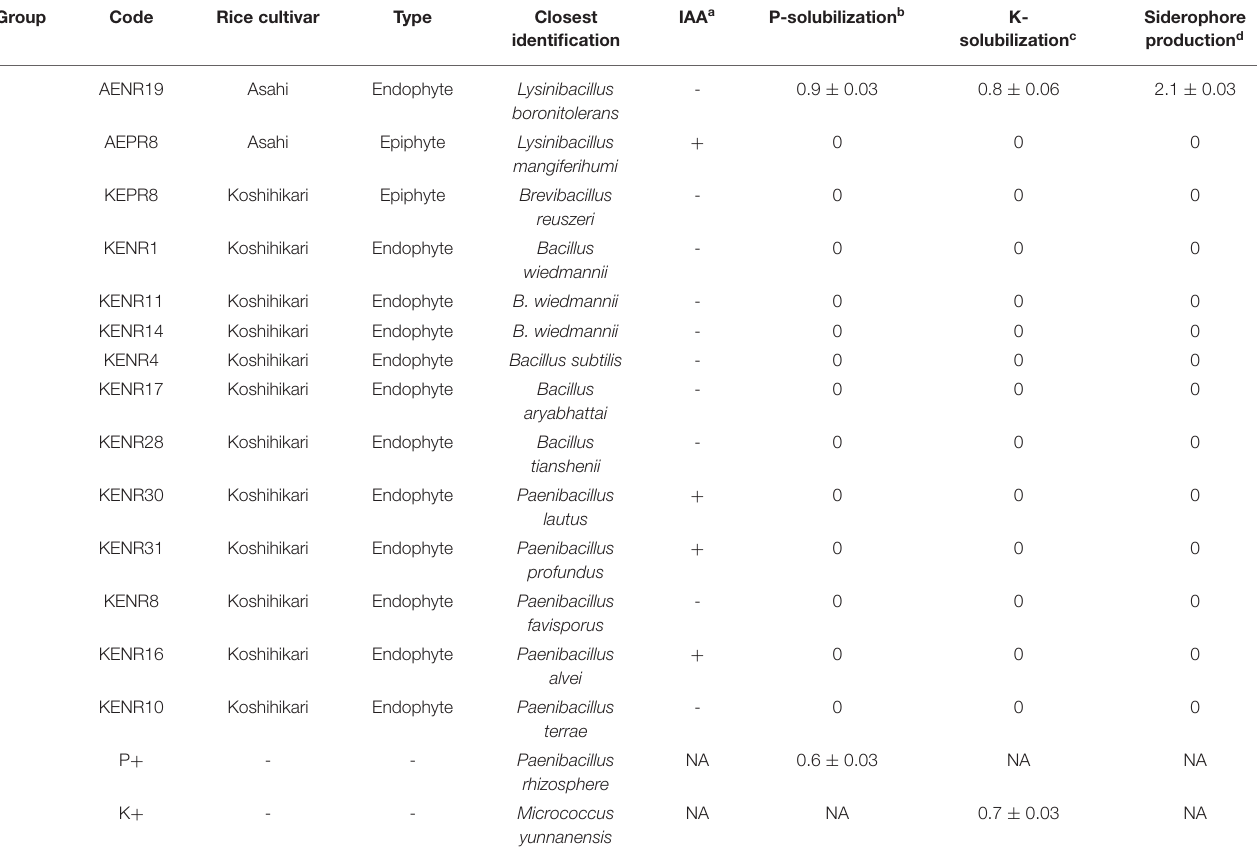
a IAA: observed based on the formation of pink color. b P-solubilization: Unit represent size of halo zone (cm) caused by dissolution of Tricalcium phosphate. c K-solubilization: Unit represent size of halo zone (cm) caused by dissolution of potassium mineral (sericite mica). d Siderophore production: Unit represent size of yellow zone (cm).